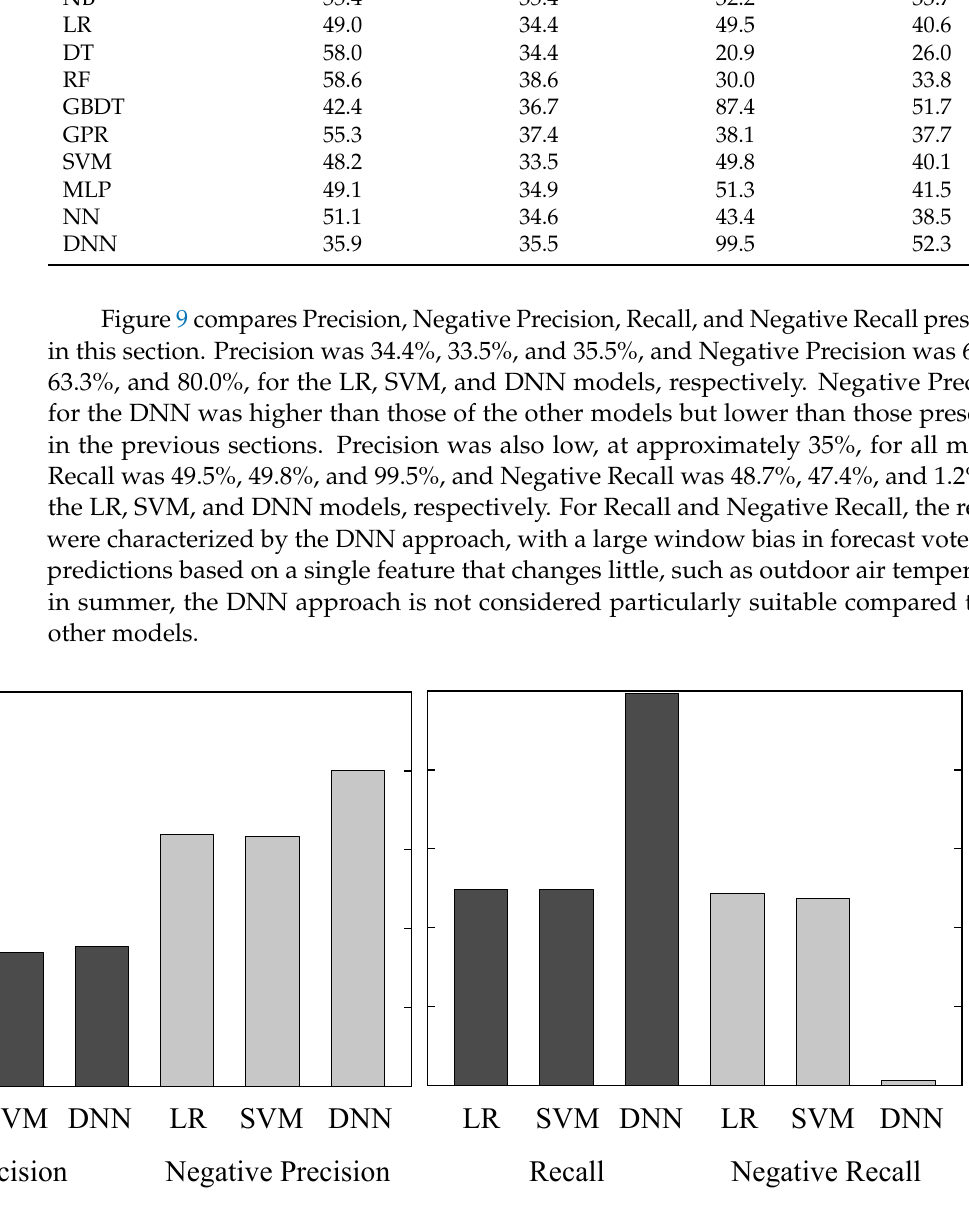
Figure 9. Comparison of Precision, Negative Precision, Recall, and Negative Recall in Section 3.6.